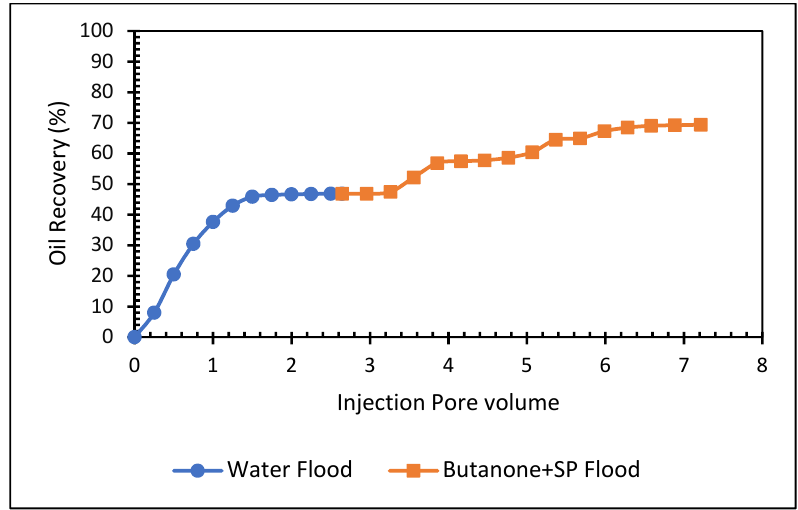
Figure 13. Total oil production from the carbonate core after brine, butanone, and SP mixture, followed by a post-flood with brine.